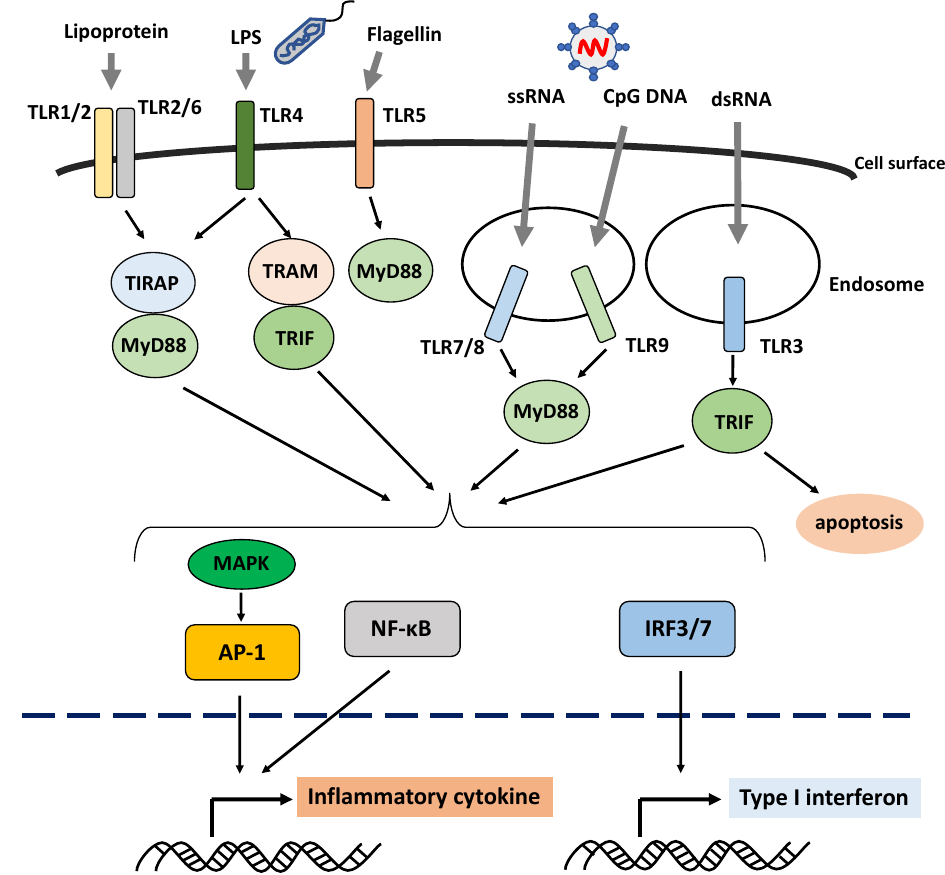
Figure 1. Schematic overview of the activation of the Toll-like receptor signaling pathway. Toll-like receptors (TLRs) are the pattern-recognition receptors, which recognize different pathogen- or danger-associated molecular patterns. TLR1, TLR2, TLR4, TLR5, and TLR6, which are involved in the recognition of proteins and fats, are mainly localized on the cell surface, whereas TLR3, TLR7, TLR8, and TLR9, which are involved in the recognition of nucleic acids, are mainly localized within the cells in the endosomes and endoplasmic reticulum. The TLR recognition of their ligands leads to the production of inflammatory cytokines and type I interferon via downstream molecules. Abbreviations: AP-1: activator protein 1; IRF: interferon regulatory factor; LPS: lipopolysaccharide; MAPK: mitogen-activated protein kinase; MyD88: myeloid differ- entiation primary response 88; NF- κ B: nuclear factor kappa B; TIRAP: toll/interleukin-1 receptor domain-containing